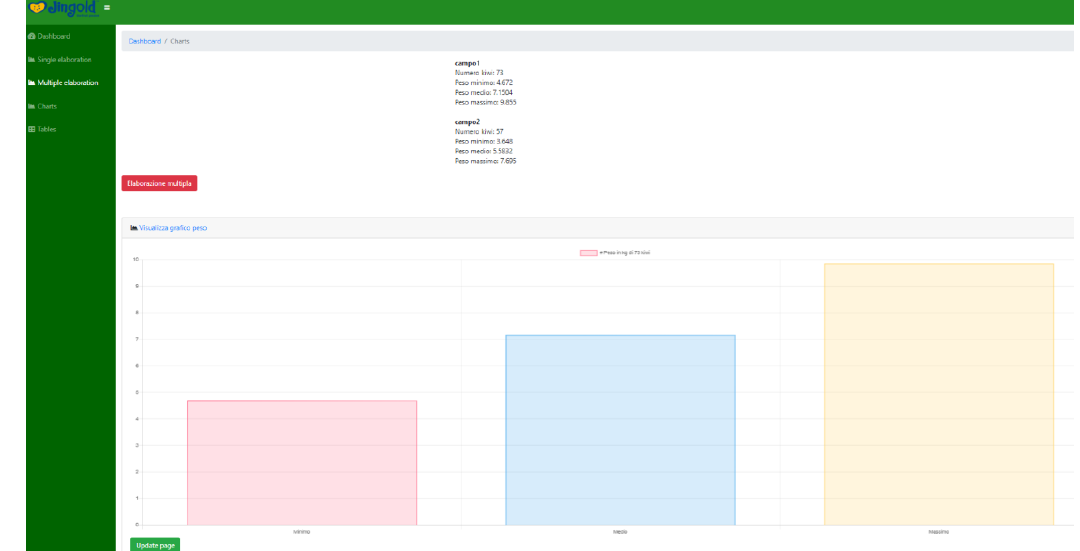
Figure 21. Yield estimation statistics.